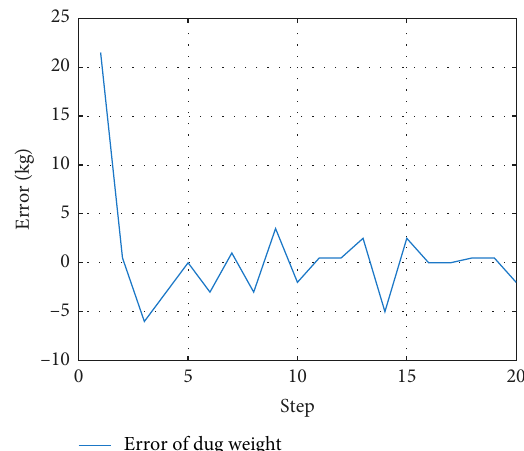
� 0.1 and k � 0.9. T J